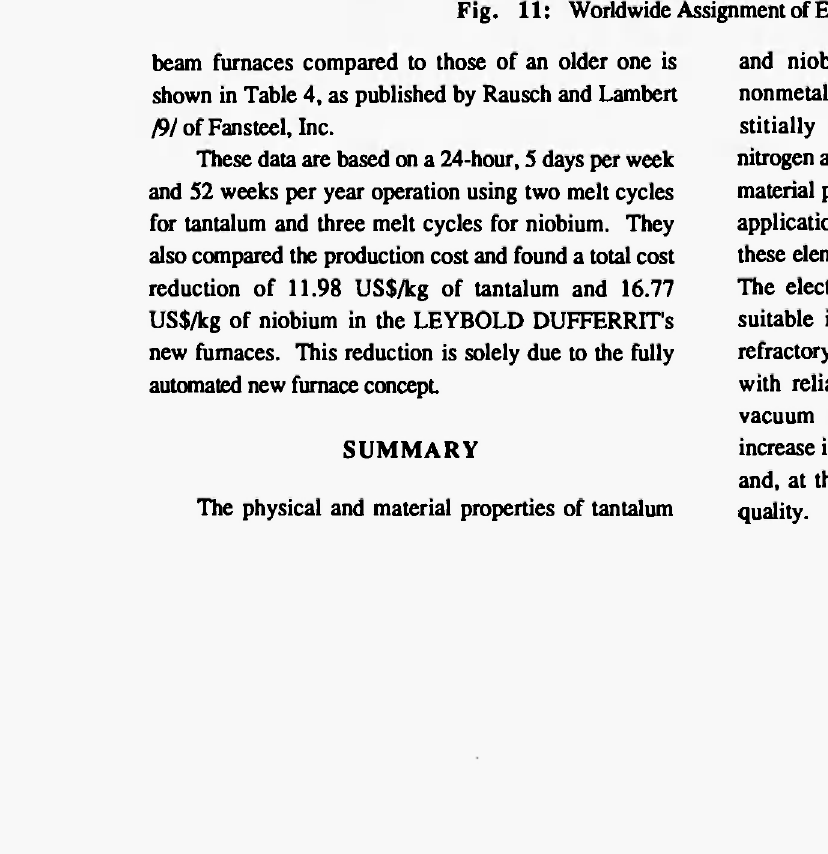
Fig. 11: Worldwide Assignment of